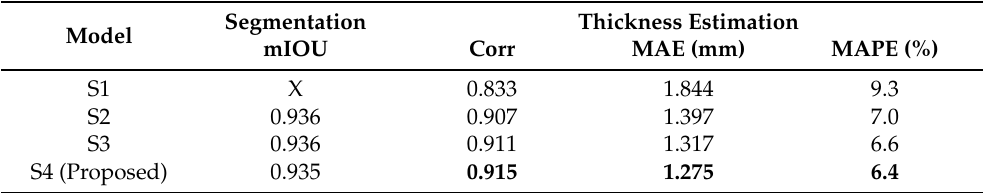
Table 2. Performance of three different scenarios for the ablation study.